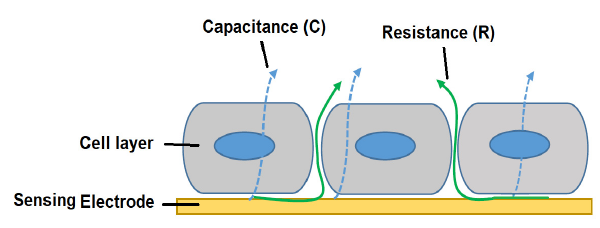
Figure 8. A schematic drawing of an Electric Cell Substrate Impedance Sensing system (ECIS): The insulating membranes of the cells attached to the sensing electrode, cause capacitance (C) by constraining the current and force the current to flow beneath and between the cells which causes resistance (R), therefore in ECIS both the capacitance and resistance contribute to the measured impedance